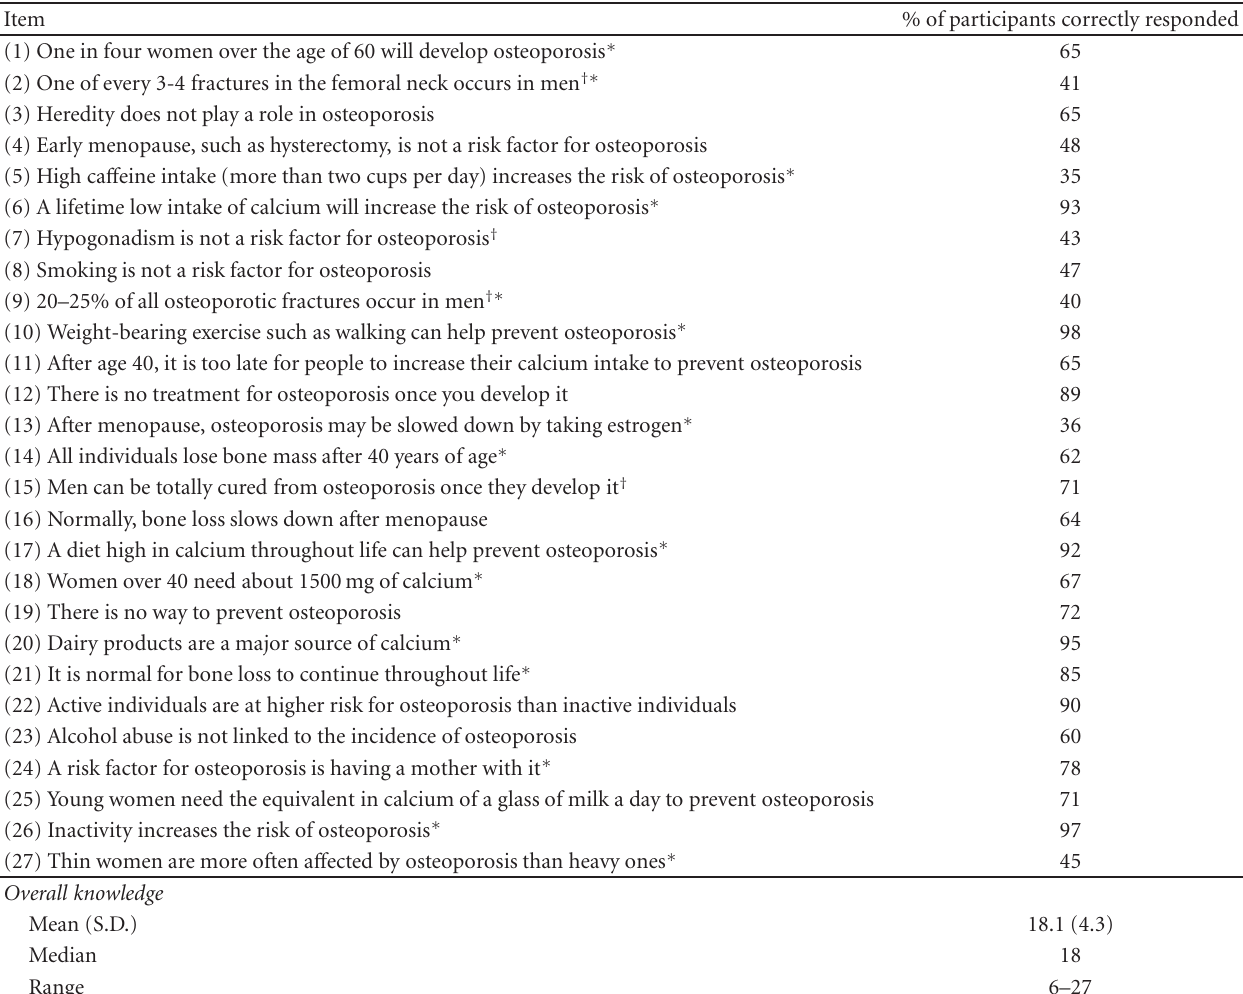
Table 2: Percentage of participants responding correctly to knowledge items ( n = 100).